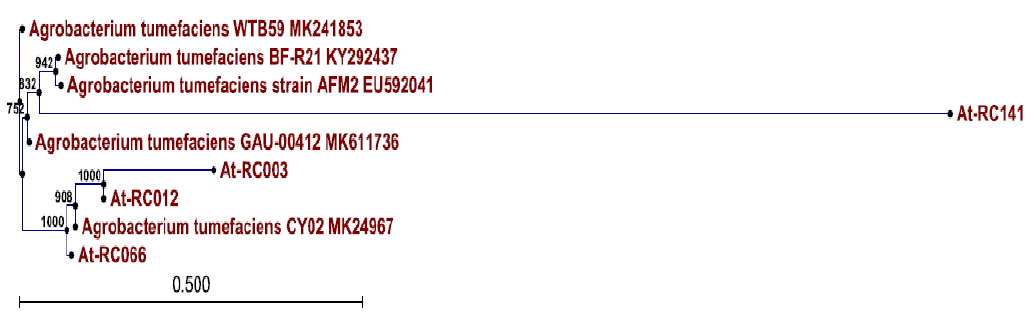
Figure 4. Neighbor-joining tree based on 16S rDNA sequences of isolates. Standard reference strains have strain numbers followed by Genebank accession no. RC012 and RC066 were pathogenic, whereas RC003 and RC141 were nonpathogenic isolates of A. tumefaciens . Bootstrap values based on 1000 replications are indicated as numbers in internodes.